Question: From the figure, is the trend upward or downward?
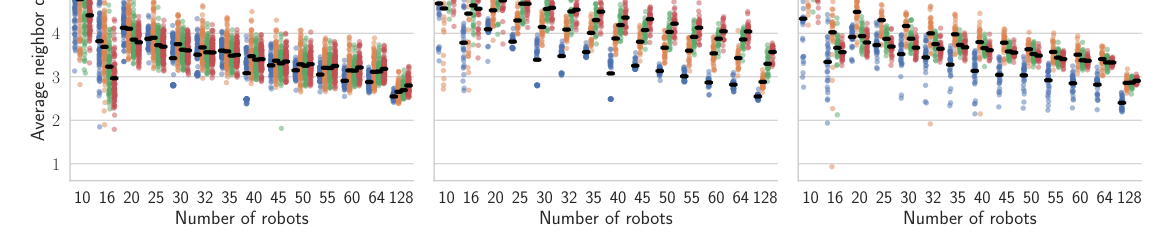
Answer: increasing